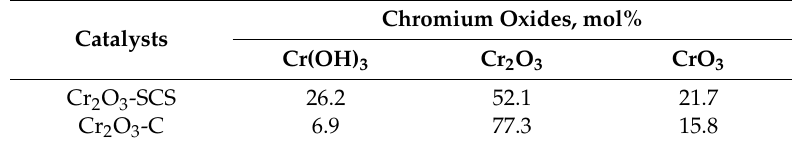
Table 3. Surface composition of chromium oxides based on the deconvolution of XPS peaks (Cr 2p 3/2 ).